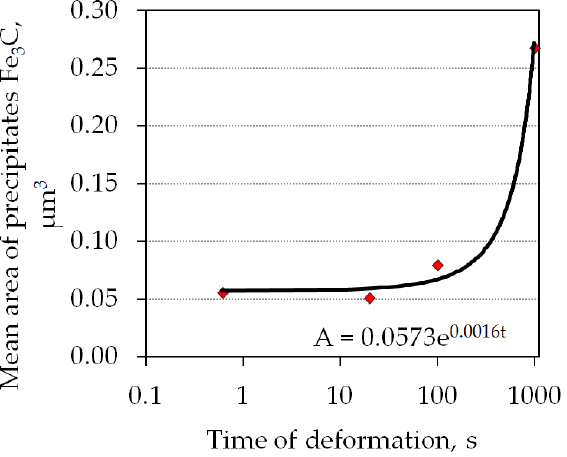
Figure 6. Mean surface area of Fe 3 C precipitates as a function of time of deformation.